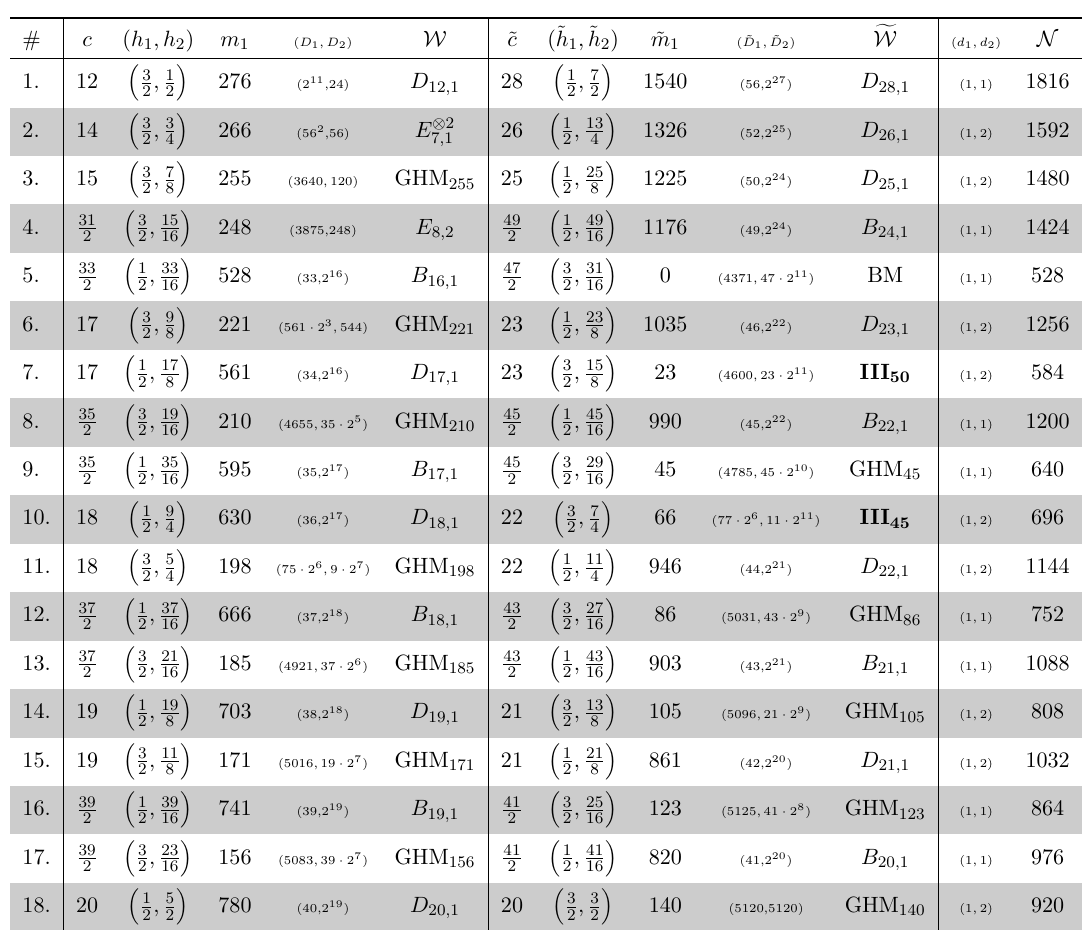
Table 19. CFT pairings, c H = 40 with ( n 1 , n 2 ) = (2 , 4) . The character of the meromorphic theory is j 2 ( j − 1240 + N ) with N given in the last column of the table. 3